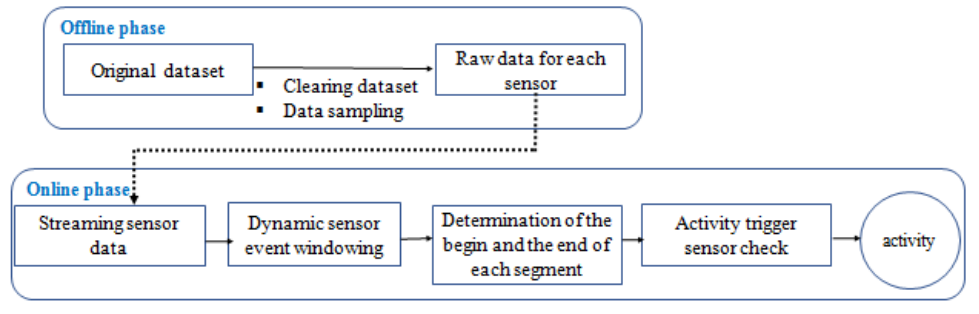
Figure 5. Diagram of the online HAR